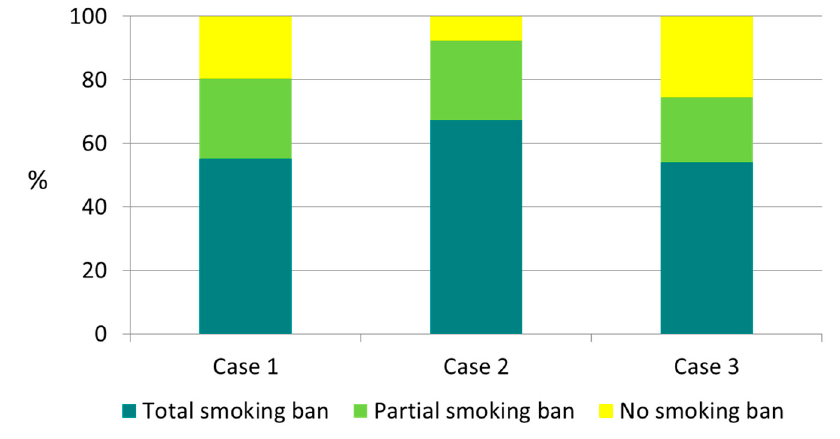
Figure 3. ETS exposure profile when the cohabitant smoker was only the mother (case 1), when the cohabitant smoker was only the father (case 2), and when mother and father were both smokers (case 3).